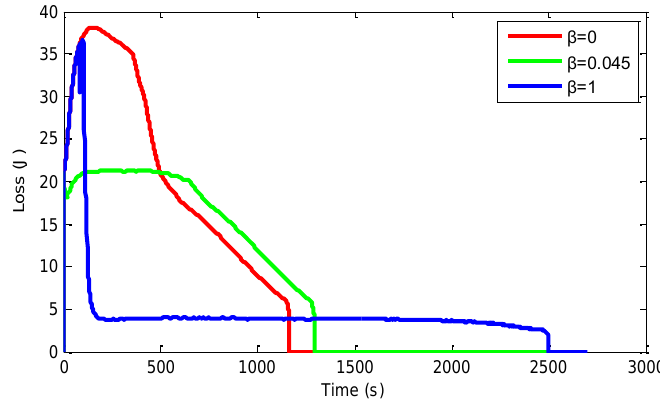
Figure 6. The dynamic property of energy loss under different